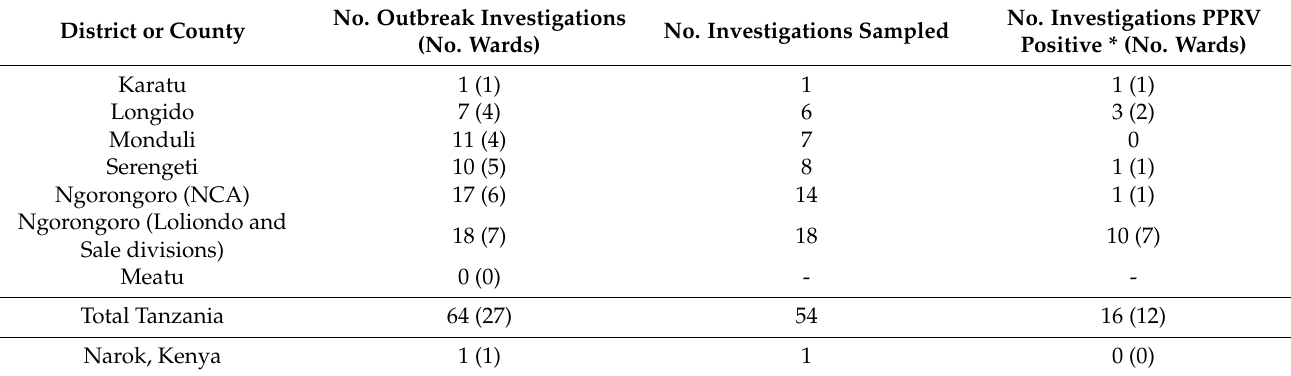
Table 6. Investigation of peste des petits ruminants (PPR)-like disease in sheep and goat flocks in the study area